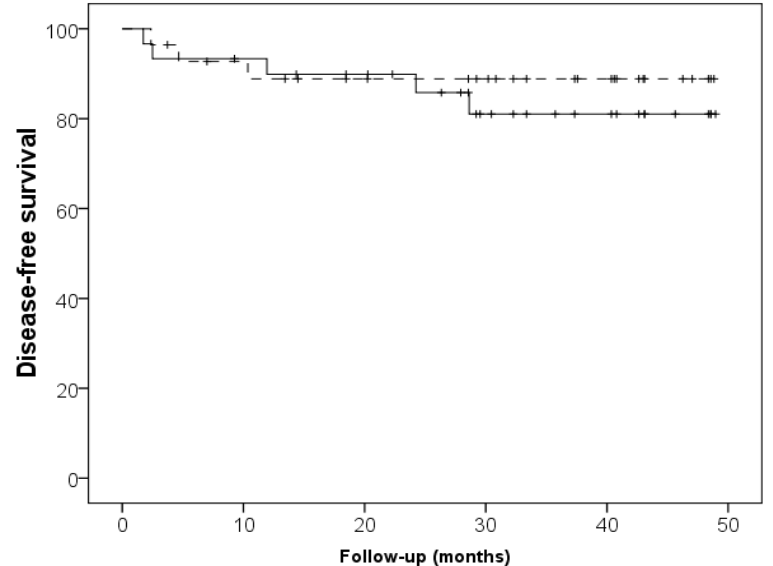
Figure 3. Cardiovascular event-free survival in the probiotics group (continuous line) and placebo group (dashed line) (log rank p = 0.5).